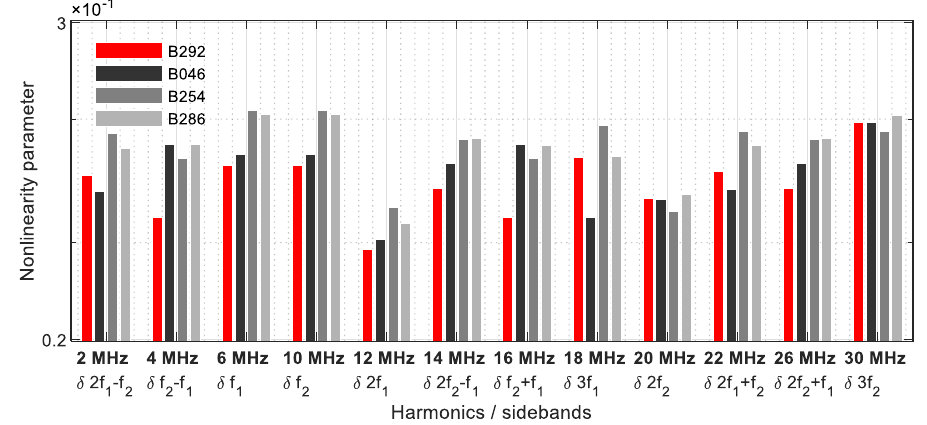
Figure 29. Nonlinearity parameter.